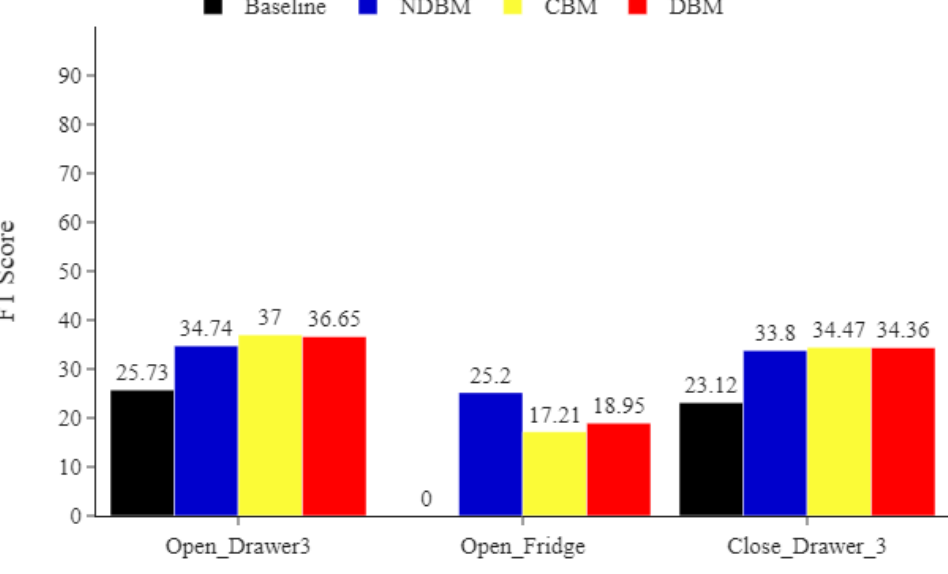
Figure 5. Opportunity minority classes. Comparing the impact of DBM, NDBM, and CBM on activity recognition performance, using MLP for the most underrepresented activities Open_Fridge , Open_Drawer3 , and Close_Drawer3 . The reported means of F 1 scores are obtained from 30 repetitions. The F 1 score is in %.